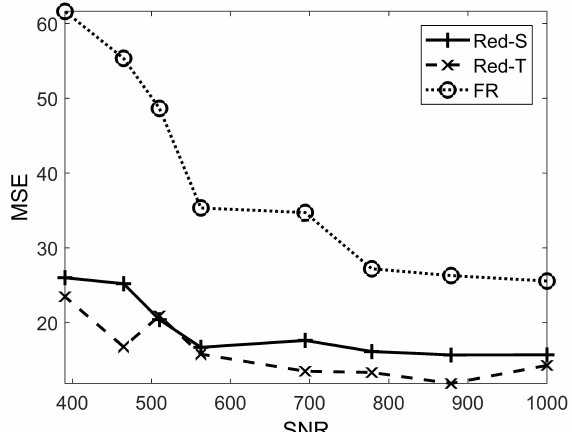
Figure 5. ( a ) Mean squared error (MSE) of naive source localization. ( b ) MSE of Red-S, Red-T, and FR in different number of nodes ( N ). P 0 = 1000 and the local false alarm probability p fa = 0.1 have been considered in simulations.